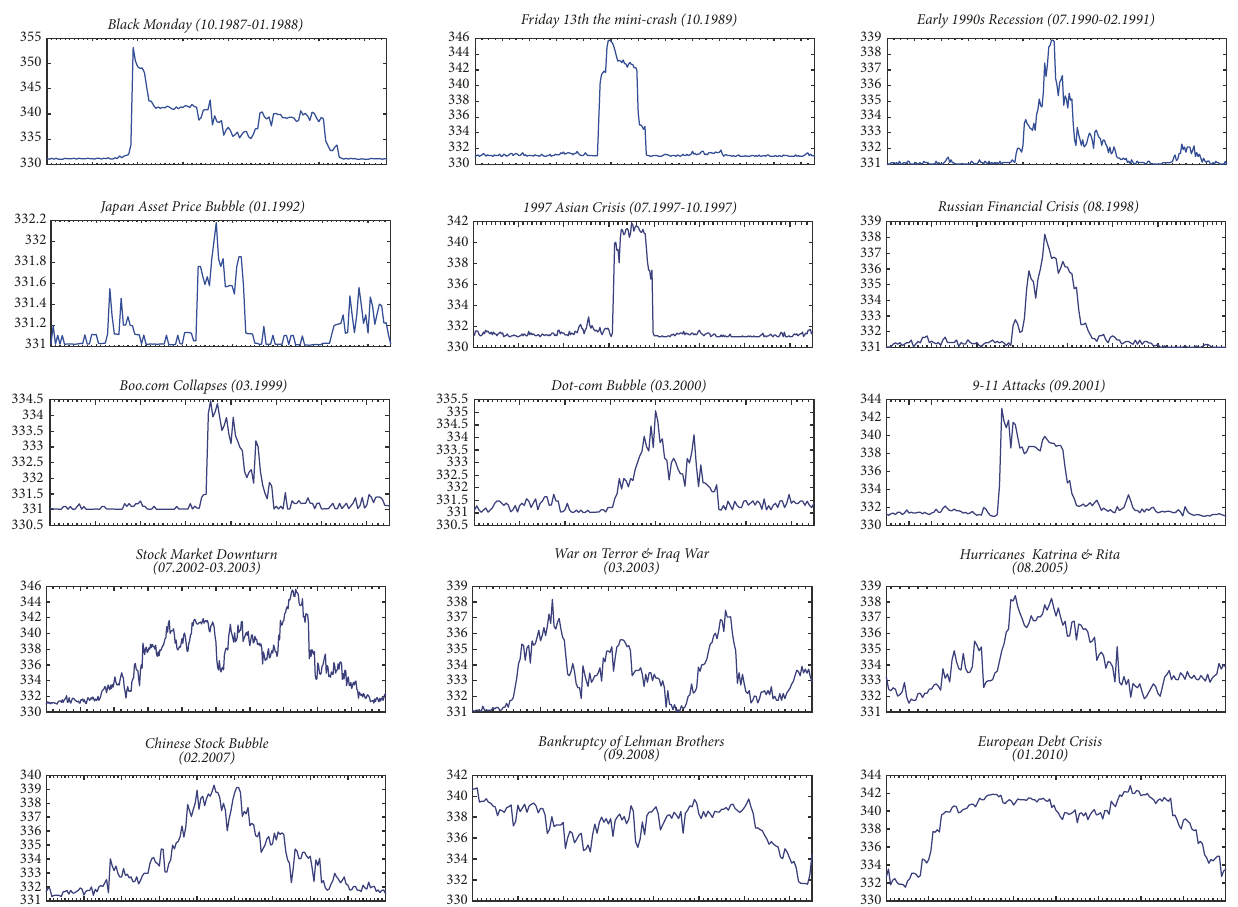
Figure 4: The individual time series of the stock market network. The thermodynamic entropy for all the different global events that have been